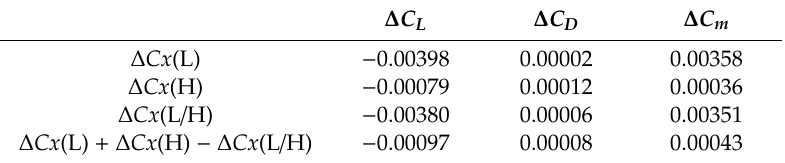
Table 11. Coupling relationship between parameters H and L ( Ma = 0.75, α = 0 ◦ ).